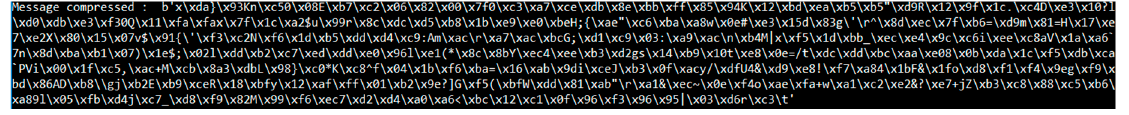
Figure 9. Compressed string.